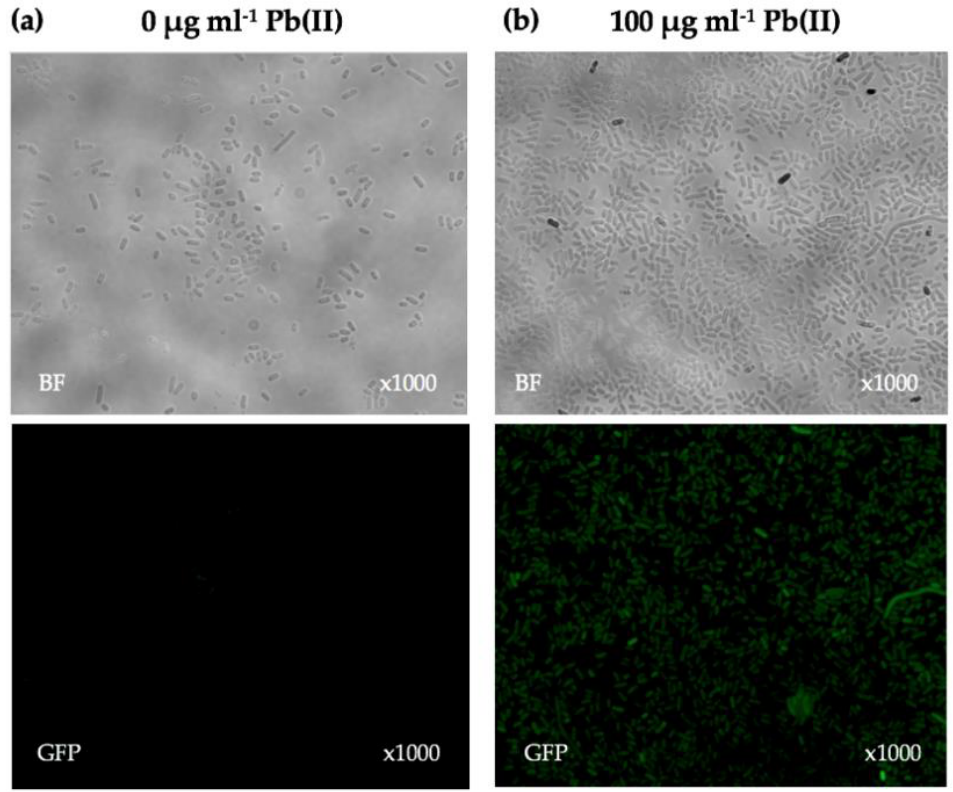
Figure 2. Bright-field ( top ) and fluorescence ( bottom ) microscopy images of E. coli DH5 α (pBB pbrRgfp ) NYB-cultures ( a ) uninduced, and ( b ) induced, with 100 µg·mL −1 Pb(II) for 24 h at 37 °C.